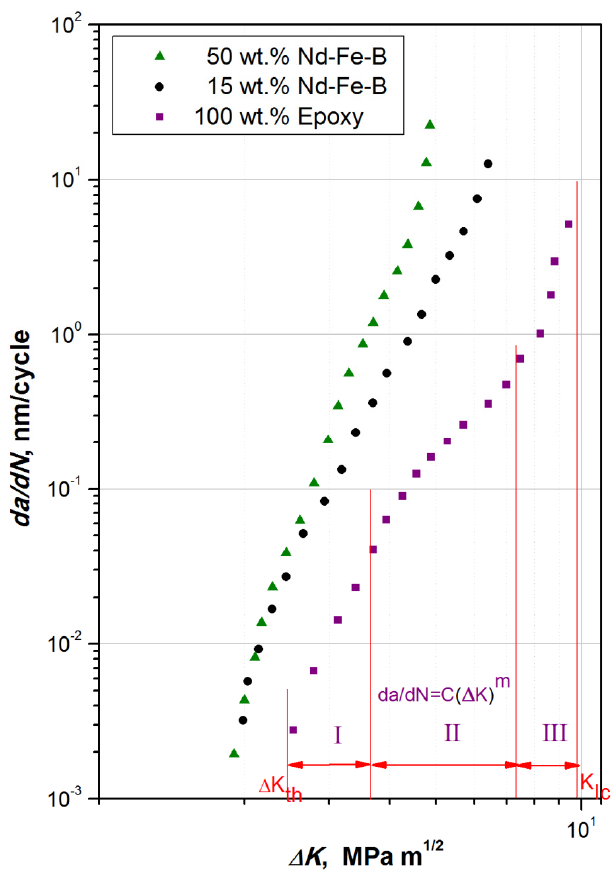
Figure 11. Diagram da/dN vs. Δ K for pure matrix and composites with 15 and 50 wt.% of Nd-Fe-B. The values for C and m for a particular composite composition were obtained by constructing a straight trendline onto the log-log plot of the experimental data (in the lin- ear area, also known as the “Paris” area, where m represents the slope and C represents the intercept). Table 2 shows that m value is the lowest for pure epoxy material (3.816). Moreover, m was found to increase with increasing fi ller contents. Increased m values are strongly connected with crack growth rate. Materials with low fi ller contents were found to have a lower fatigue crack growth rate and, consequently, lower values of m. Table 2. The parameters of fatigue crack growth. Specimens 0 wt.% Nd-Fe-B 100 wt.% Epoxy